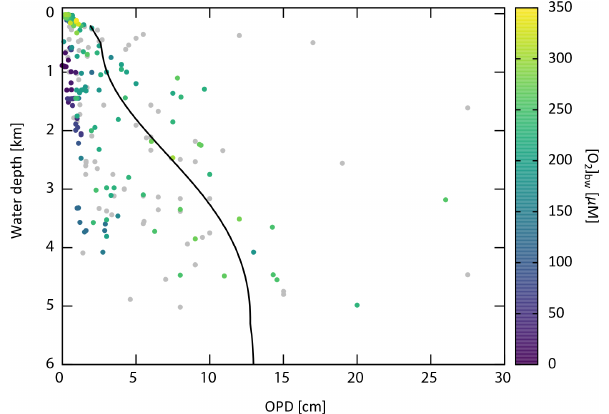
Figure 15. C org / P org ratios of buried sediments as a function of sedimentation rate. Black dots represent the observational data (In- gall and Cappellen, 1990). The simulated C org / P org ratios for the LD region obtained from our reference run is shown as a black